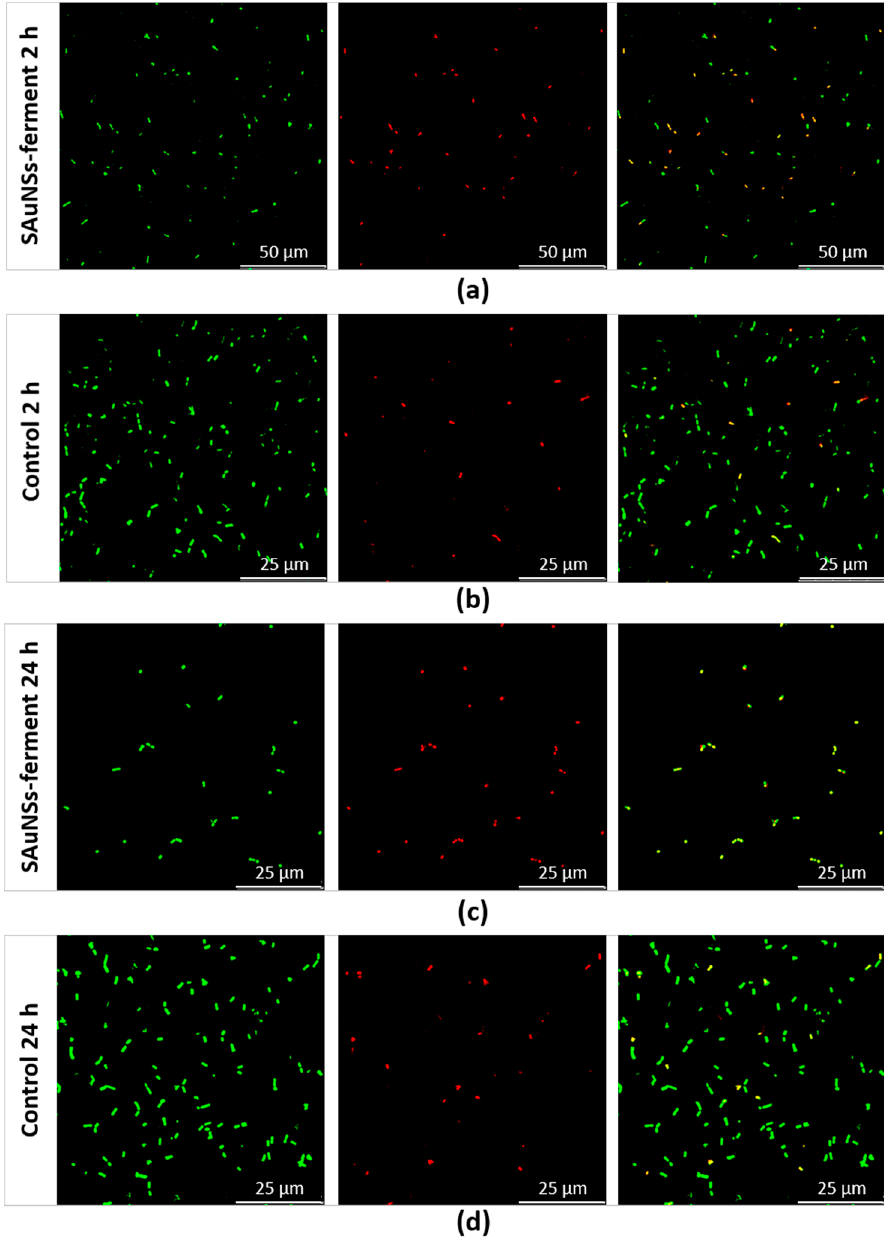
Figure 7. Confocal laser scanning microscopy images of SAuNPs–ferment after 2 h ( a ) and 24 h ( c ) incubations compared to control cultures lacking gold ions at the same times: 2 h ( b ) and 24 h ( d ). From left to right for each sample: all bacteria (spots stained green by SYTO9), dead bacteria (spots stained red by propidium iodide (PI)) and a merge of both images, where green and yellow spots corresponds to live and dead bacteria, respectively.